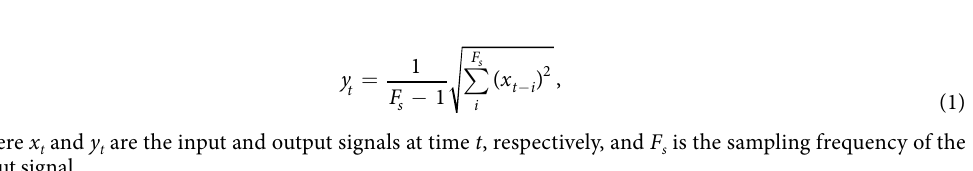
Figure 1. Examples of EEG/EMG signals in each stage. ( A ) WAKE, ( B ) non-REM, and ( C )